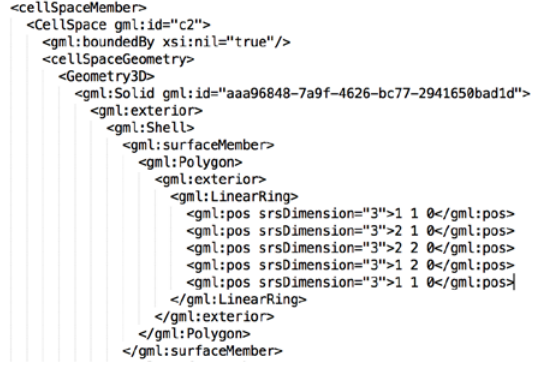
Figure 6. Part of the IndoorGML document